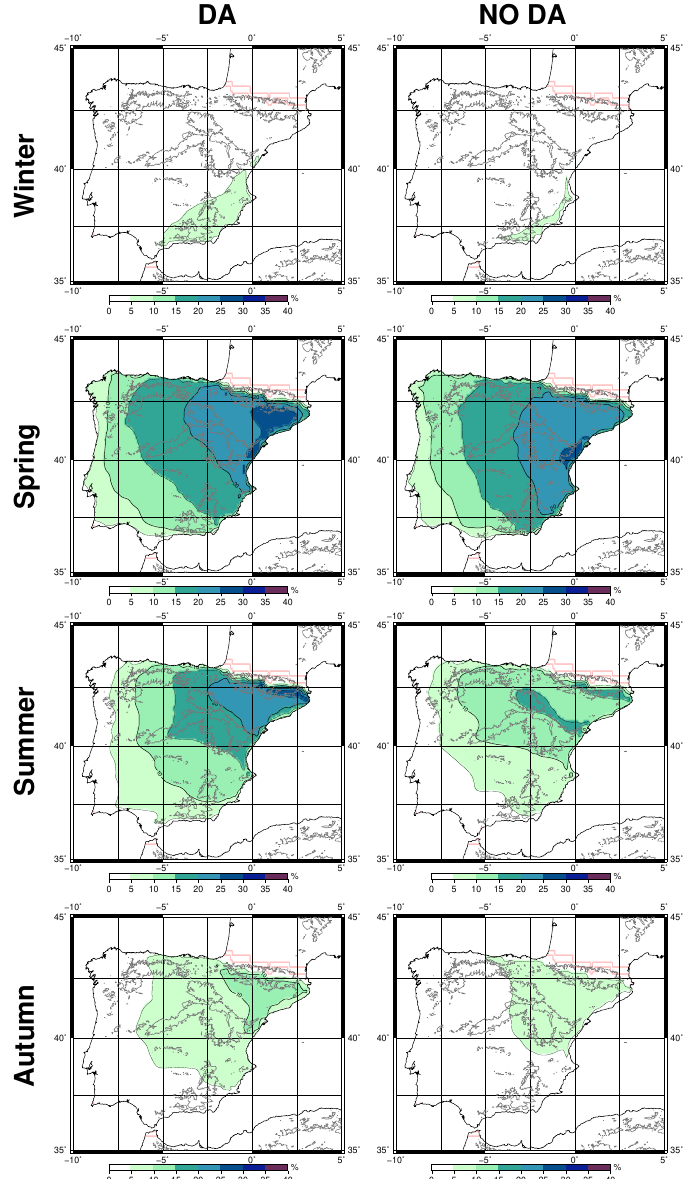
Figure 4. Spatial distribution of moisture recycling in both WRF simulations (WRF D in the first column, and WRF N in the second one) along the different seasons: Winter (first row), Spring (second), Summer (third) and Autumn (fourth). The topography of the IP, as represented in the ETOPO1 dataset [64], is also